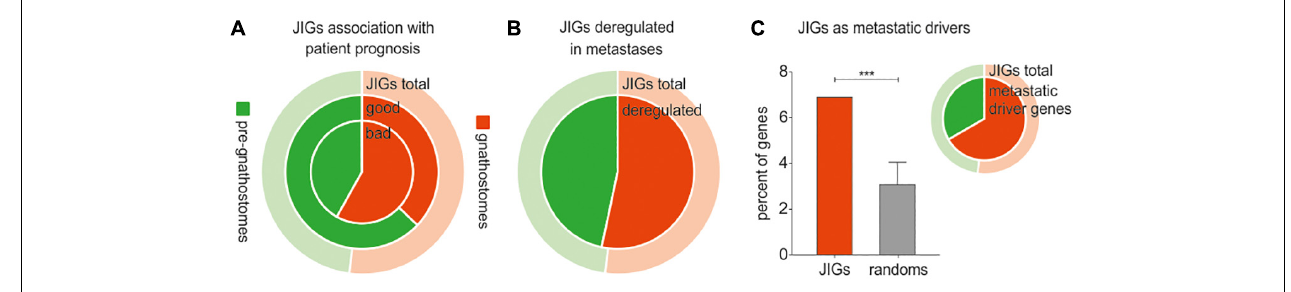
FIGURE 6 | Cancer progression and metastasis are associated with deregulation of evolutionarily younger JIGs. Red indicates gnathostome-specific, green indicates pre-gnathostome orthologs. In all pie charts, the outer, ring represents the composition of the total 305 JIGs in gnathostome-specific (light red) and pre-gnathostome (light green) JIGs. (A) Cox regression analysis of JIGs in PanCan revealed that 51.6% of gnathostome-specific orthologs predict worse and only 20.1% better prognosis (ratio 2.56:1) versus 40.4 and 37.0% (ratio 1.09:1) in pre-gnathostome genes. (B) In metastasis, a slightly higher number of gnathostome-specific JIGs is deregulated compared to the pre-gnathostomes (inner circle). (C) Estimation of gnathostome versus pre-gnathostome genes that are deregulated in a setting of xenograft experimental evolution. Diagram: among the 700 genes which were identified as drivers of tumor evolution, significant enrichment of JIGs was found (6.89%, or 21 genes) as compared to random lists (3.08 ± 0.98%). Pie: of the 21 deregulated JIGs, 14 (66.7%) were of gnathostome and 7 (33.4%) of pre-gnathostome